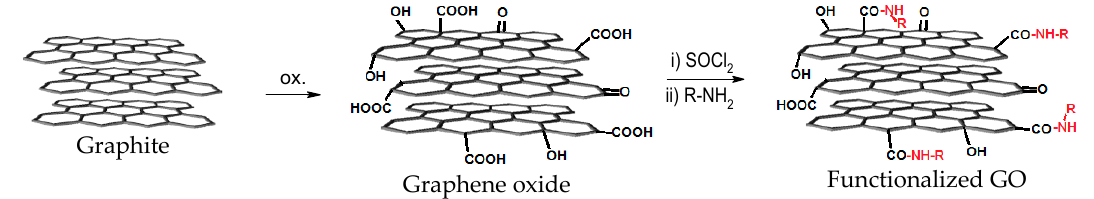
Figure 2. Synthesis and functionalization of graphene oxide with amines.